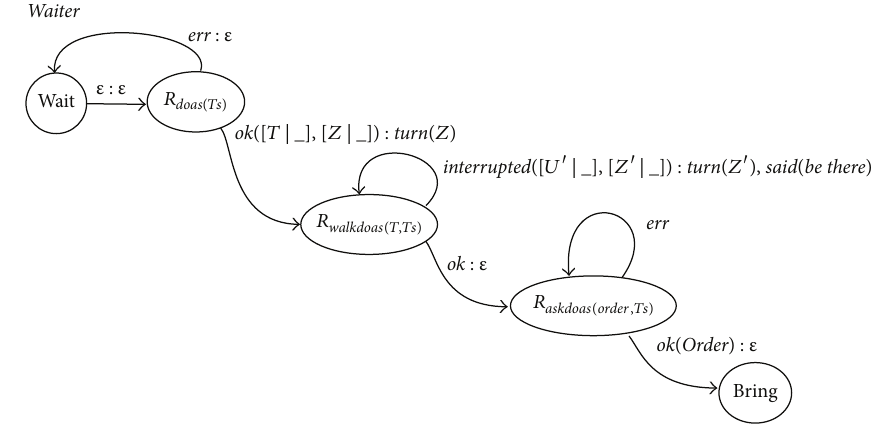
Figure 12: The DOA behaviours used on the waiter